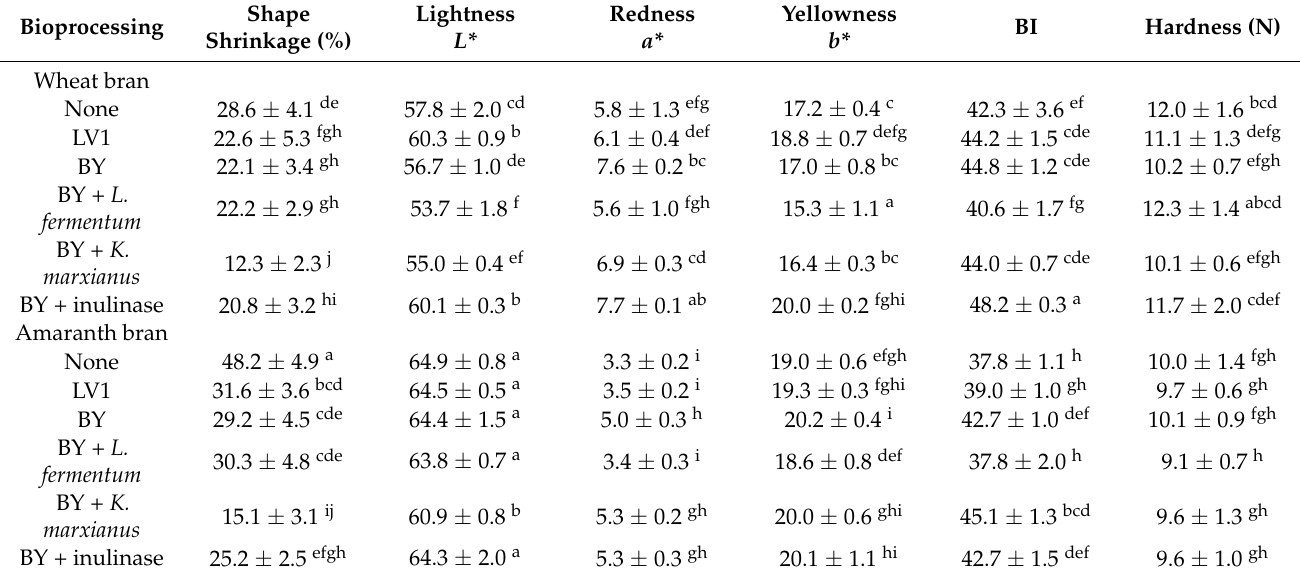
Table 3. Physical properties of baked